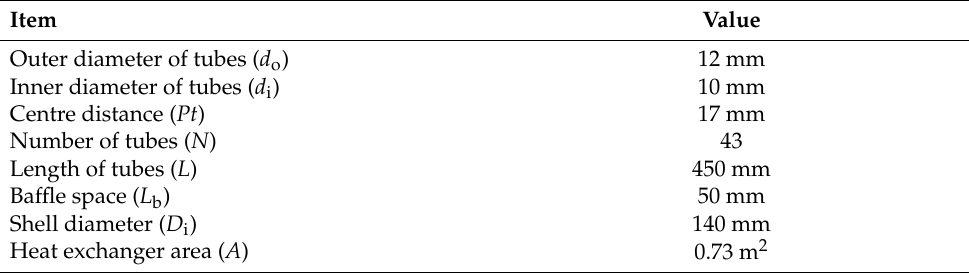
Table 4. Designed parameters of a heat